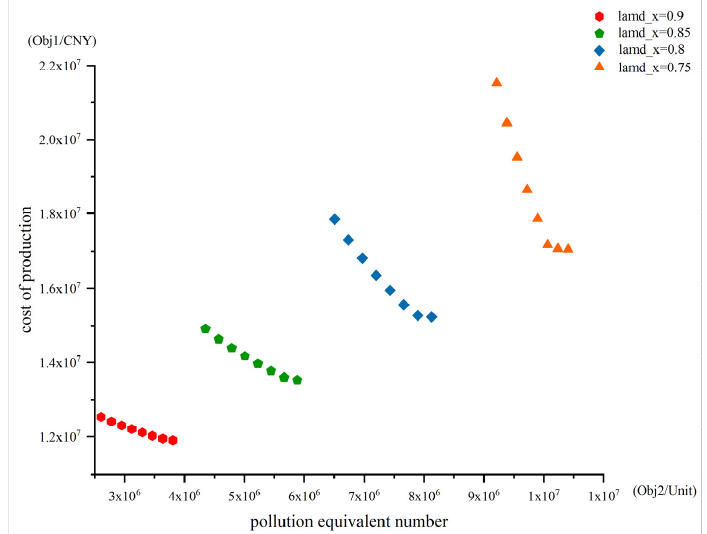
Figure 4. Dual-objective Pareto optimal solution set under different values of λ i